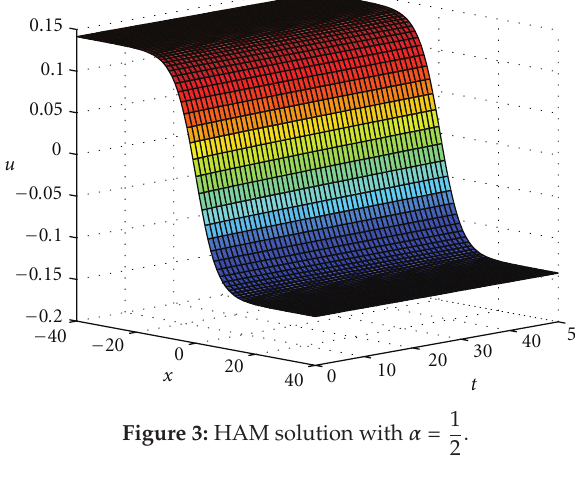
Figure 3: HAM solution with α (cid:8)